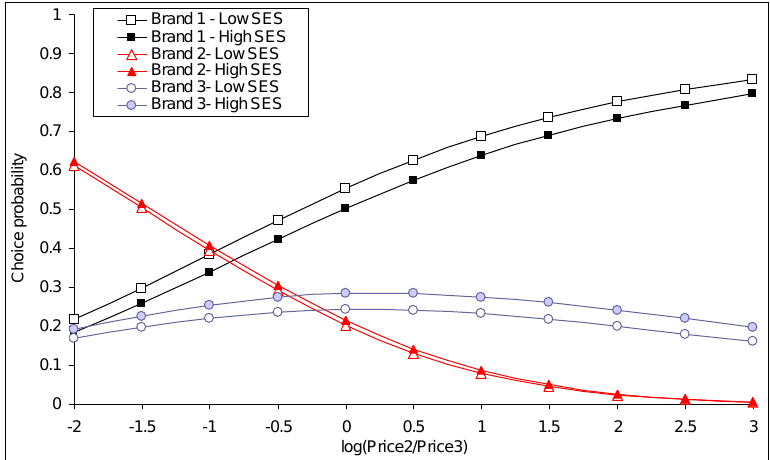
Figure 10 The impact of changes in the relative price of Brand 2 over 3 on the choice